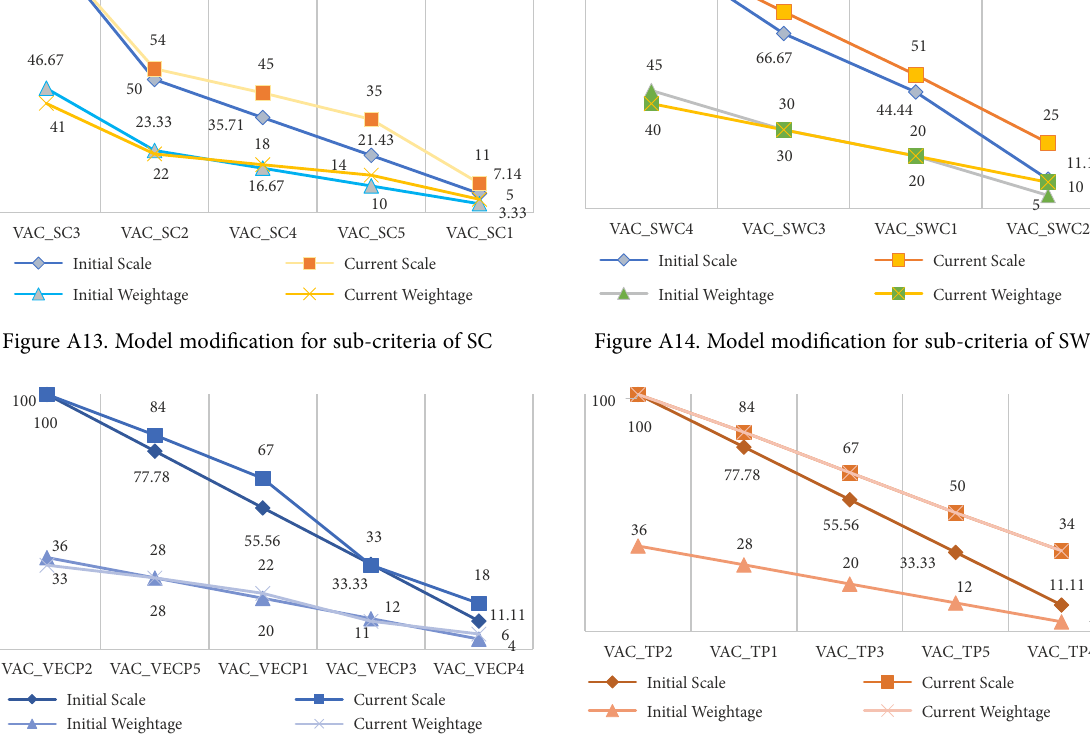
Figure A15. Model modification for sub-criteria of VECP Figure A16. Model modification for sub-criteria of